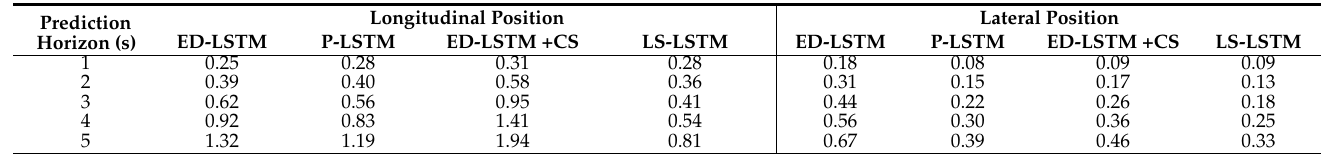
Table 2. Longitudinal and lateral RMSEs in